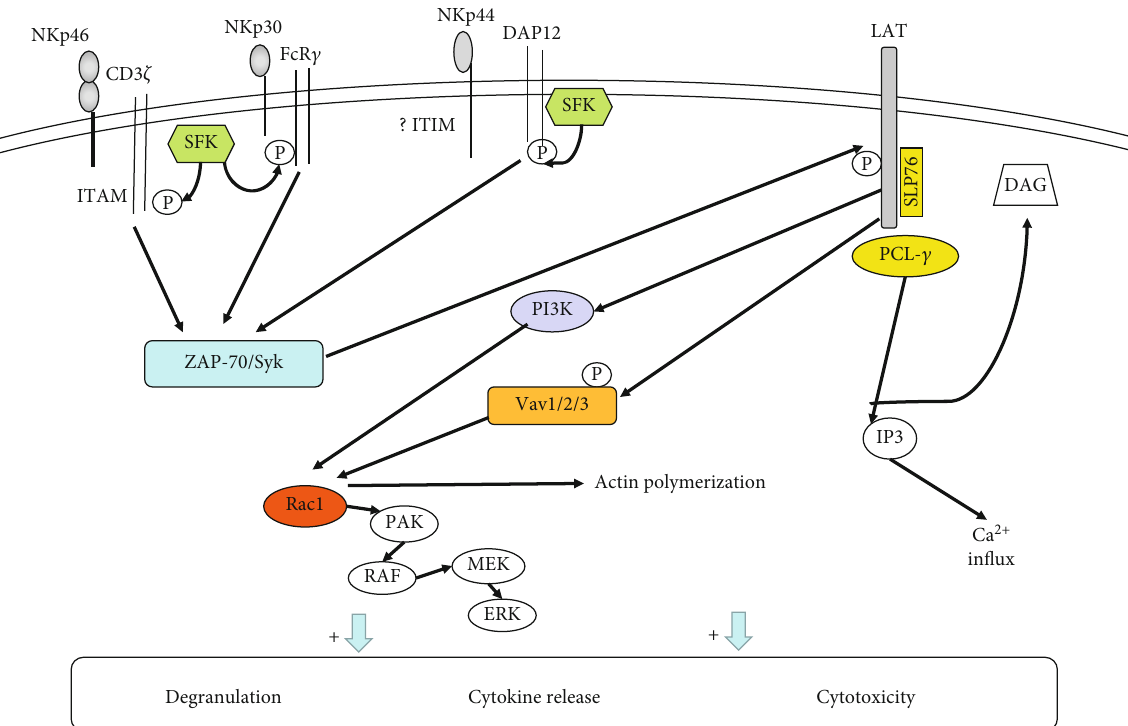
Figure 2: Model of signaling pathways by NCRs. After binding to their ligand, NKp46 and NKp30 associate with the adaptors Fc ε RI γ and/or CD3 ζ , while NKp44 binds to DAP12. Furthermore, ITAMs in the adaptor protein intracellular regions are phosphorylated by SFK. Phosphorylated ITAMs activate the tyrosine kinases Syk and/or ZAP70. This recruits and activates downstream molecules such as PLC γ , PI3K, and Vav1/2/3 with the help of LAT. PLC γ further causes Ca 2+ in fl ux. PI3K and Vav1 can recruit the small G protein Rac1 and activate the MAPK signaling pathway through cascade phosphorylation of the PAK1 – MEK – Erk signaling pathway. In addition, the intracellular region of NKp44 contains an ITIM sequence that may be related to inhibitory signaling, but the speci fi c mechanism is not yet